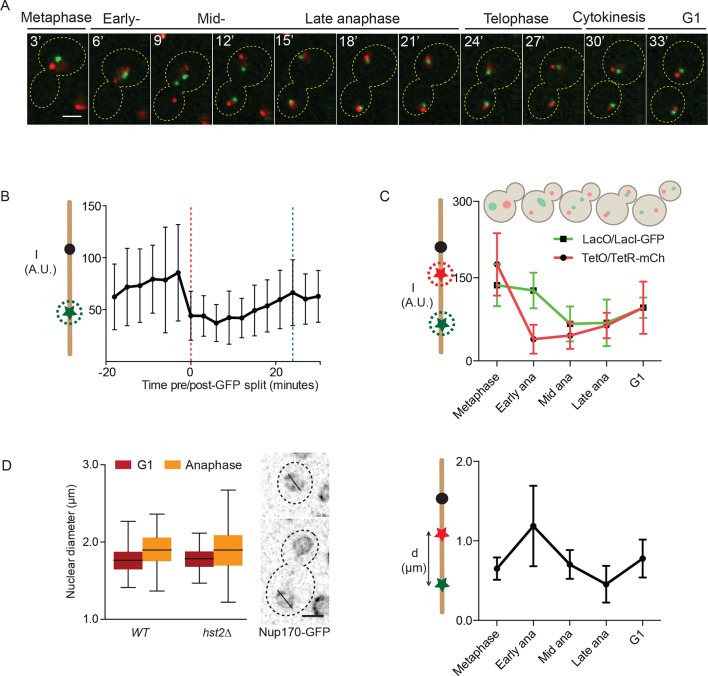
Dynamics of chromatin compaction and chromosome arm contraction.(A) Example of a cell going from metaphase to the next G1 phase with TRP1 and LYS4 loci marked with TetR-mCherry and LacI-GFP, respectively. (B) Background normalized, mean GFP-intensity values of mitotic cells, aligned at mid-anaphase (red dashed line: GFP dot split). Blue line indicates formation of the first bud. Standard deviations are shown. (C) Upper panel: normalized (to G1) intensity of TetR-mCherry and LacI-GFP foci in mother cells in the indicated cell cycle stages. Lower panel: mother TRP1:TetO - LYS4:LacO distances in indicated cell cycle stages. Shown are mean and standard deviation for n>30 cells. (D) Nuclear diameter of G1 and late anaphase cells in wild type and hst2∆ cells containing Nup170-GFP. Box shows median value, whiskers all data points n>50 cells. Scale bars are 2 µm.